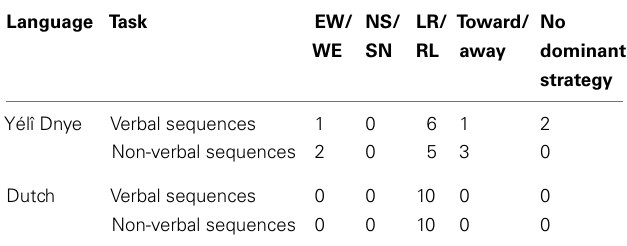
Table 6 |The dominant strategy by participants in each